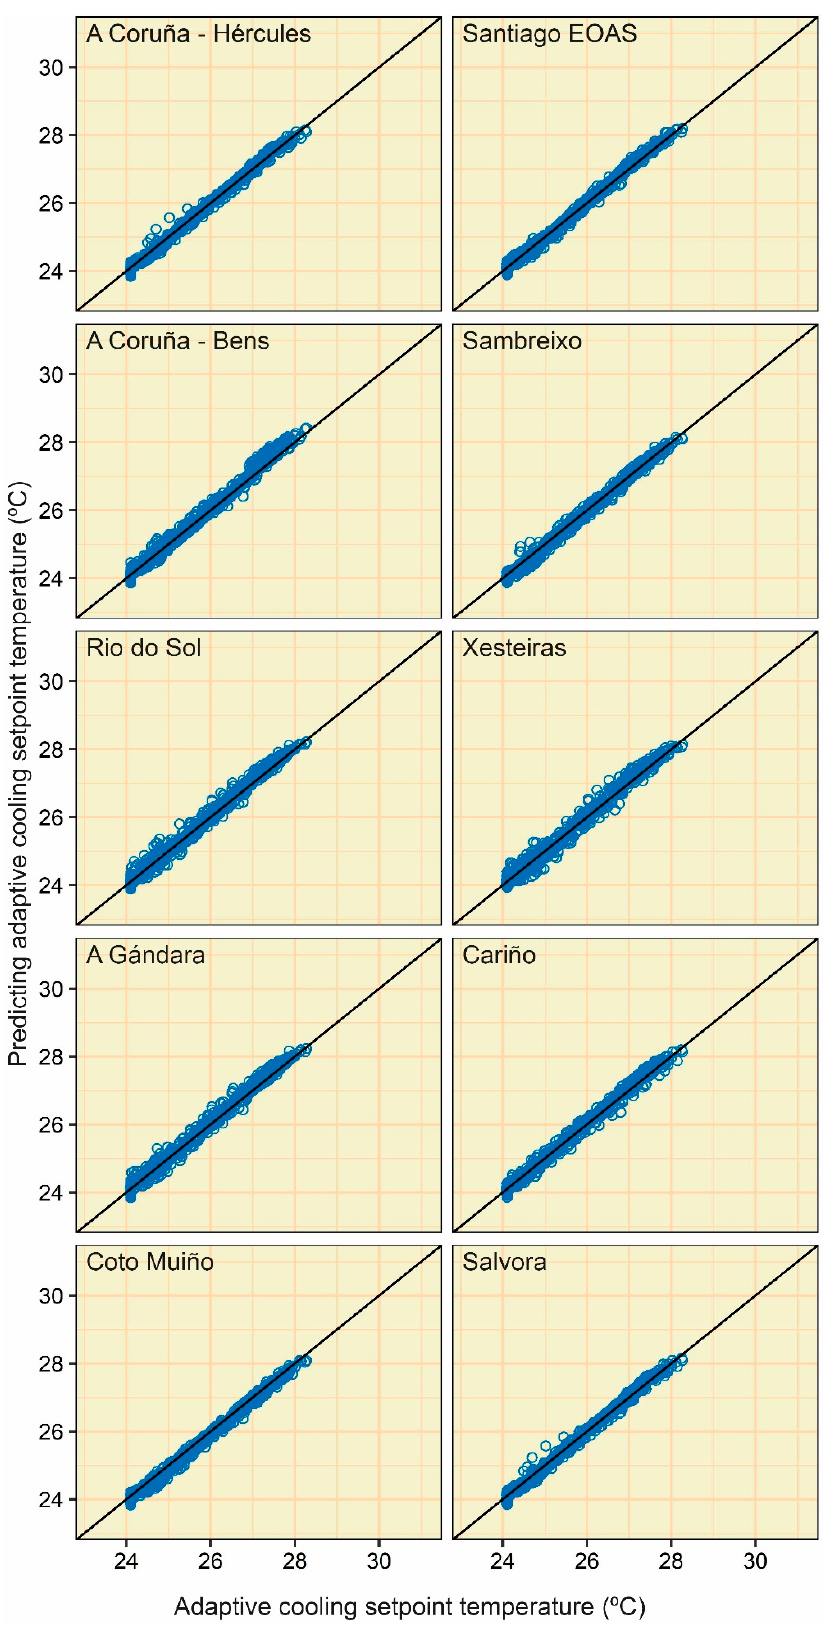
Figure A4. Point clouds between the actual and predicting adaptive cooling setpoint temperature values (category I) of the MLP (approach 1).